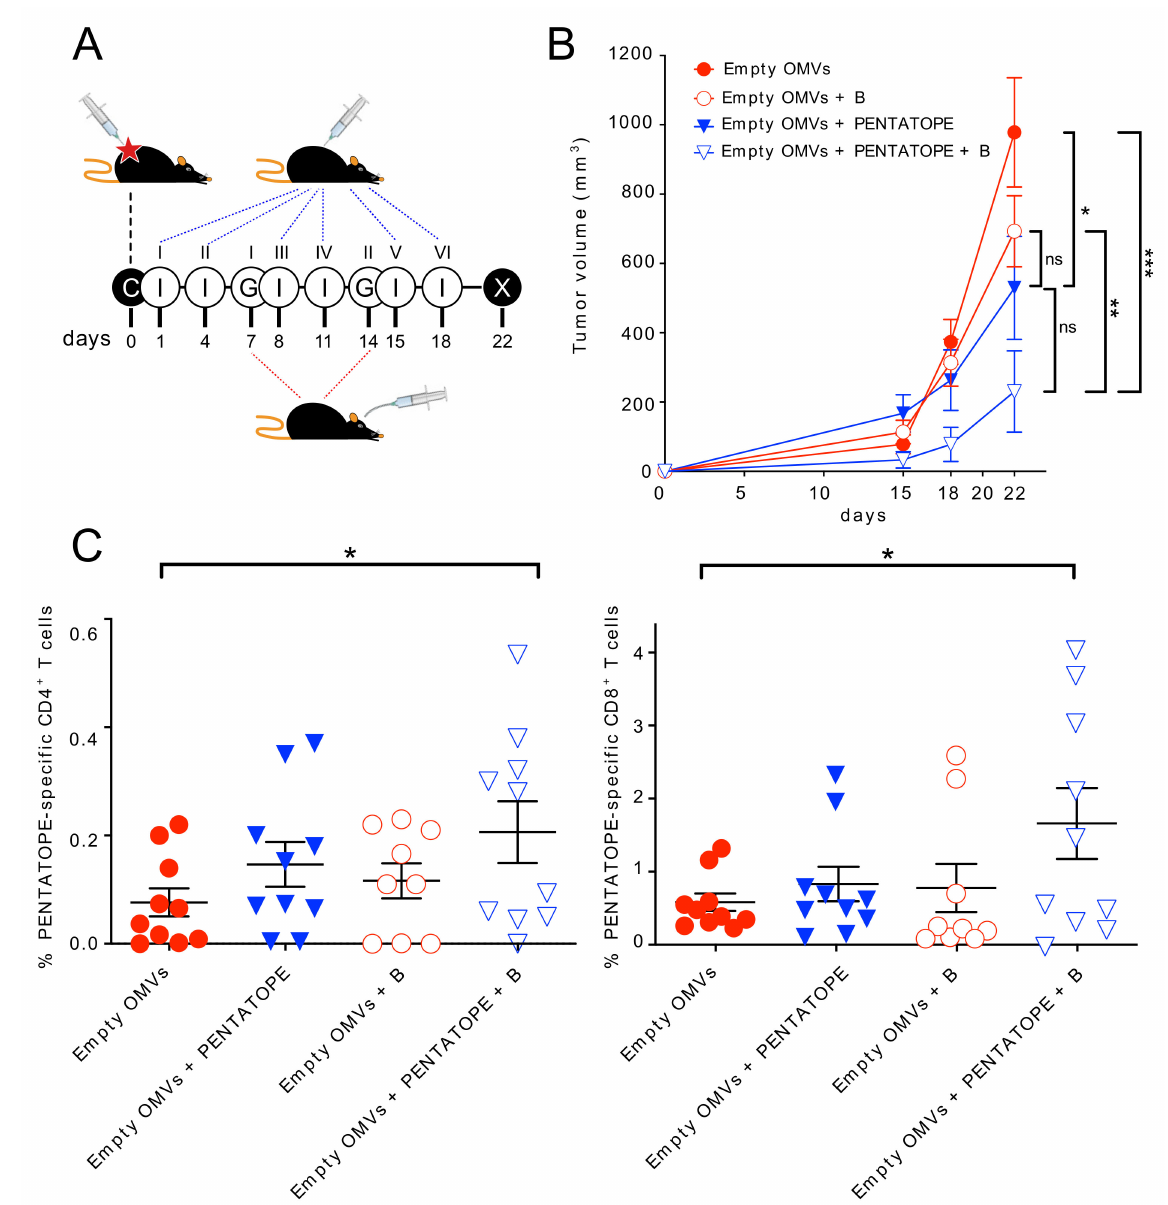
Figure 1. Effect of peptide-adsorbed OMV vaccination and Bifidobacterium administration on tumor growth inhibition. ( A ) Schematic representation of immunization schedule. Four groups of BALB/c mice (5 mice/group, two